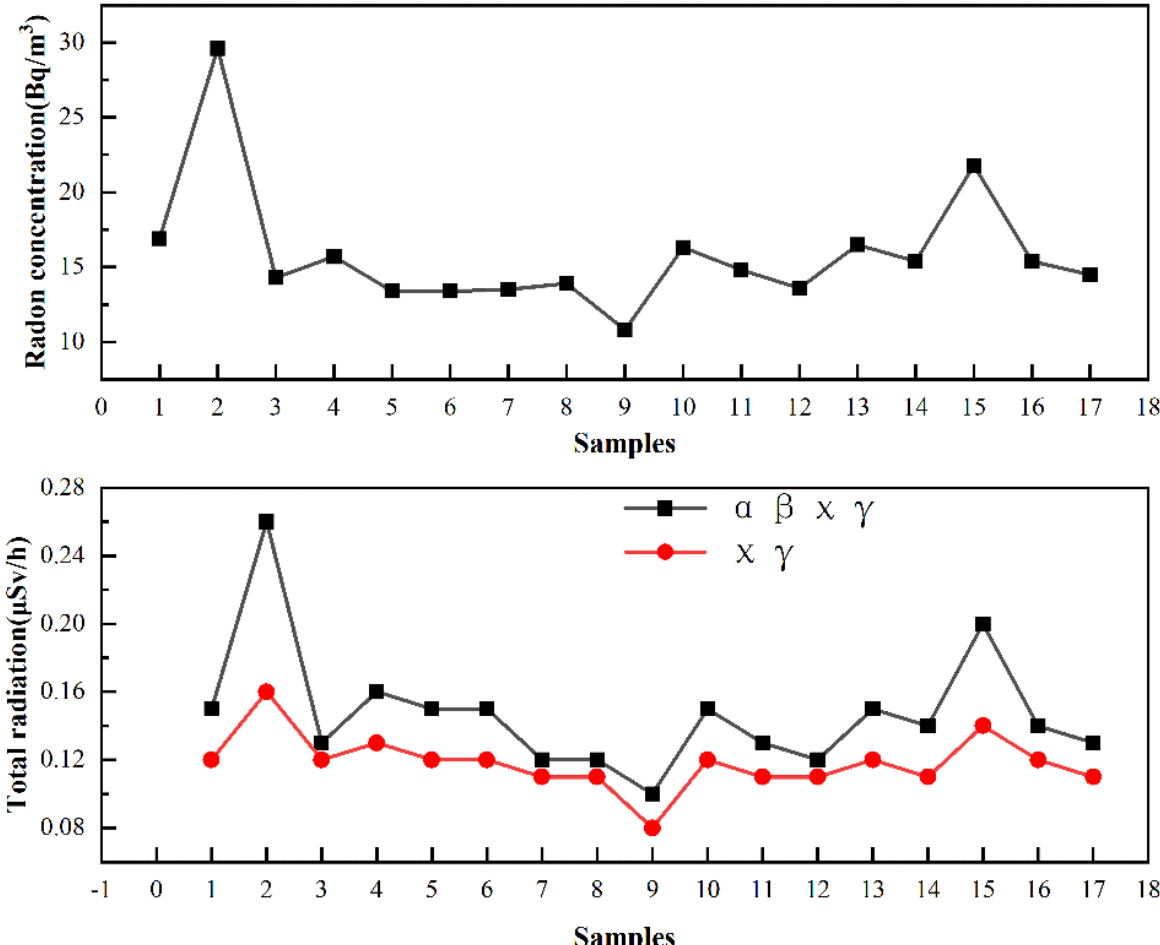
Figure 2. Radioactivity detection of tailing yard in the 17 mining areas.